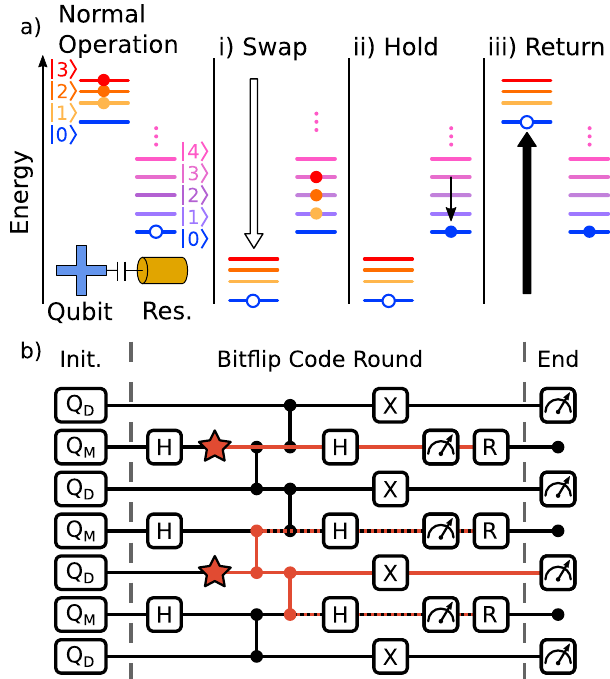
Fig. 1 Removing leakage with reset. a Schematic of the multi-level reset protocol. The qubit starts with a population in its fi rst three excited states (closed circles), with the readout resonator in the ground state (open circle). (i) The qubit is swept adiabatically past the resonator to swap excitations. (ii) Resonator occupation decays to the environment while the qubit holds. (iii) After the resonator is suf fi ciently depleted, the qubit returns diabatically to its operating frequency. The total duration of the reset protocol is about 250ns. b Circuit for the bit- fl ip stabilizer code including reset (R). Measure qubits ( Q M ) cyclically apply parity measurements to neighboring data qubits ( Q D ) using Hadamard (H) and CZ gates. We add X gates to data qubits to depolarize energy relaxation error. When introducing reset, leakage errors (stars) may be removed from both measure and data qubits, either directly or via transport through the CZ gates (red